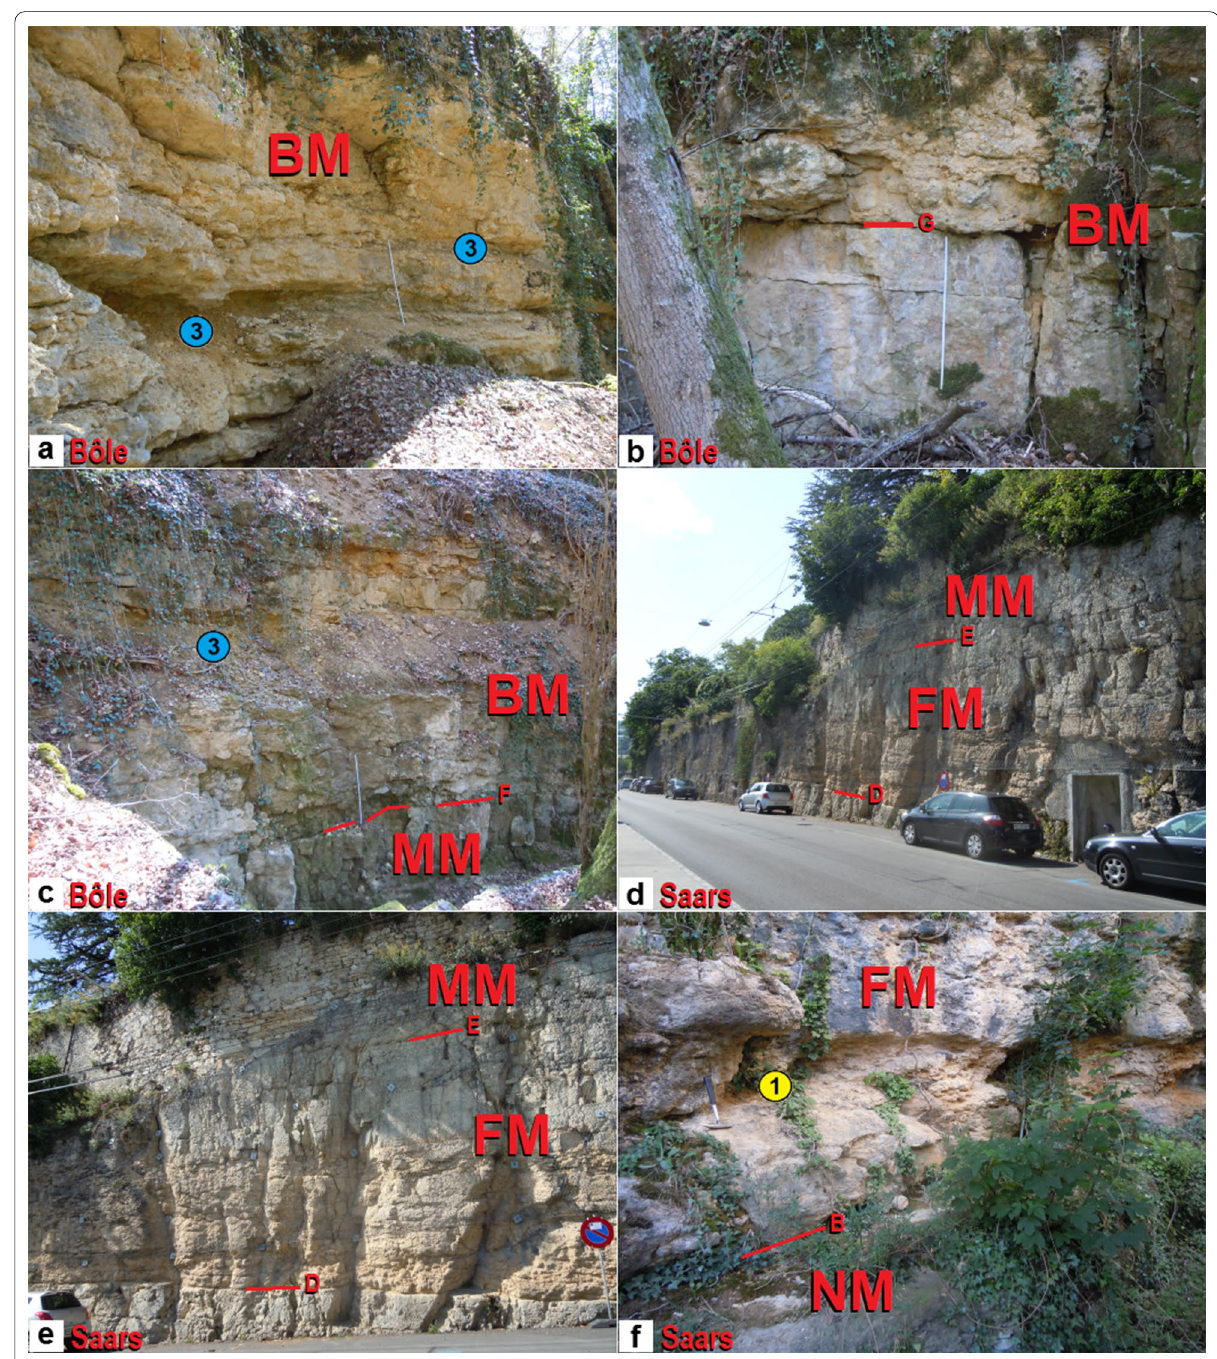
Fig. 5 Saars Formation of the Neuchâtel area (central Jura Mountains). a – c Bôle section. d – f Les Saars‑Le Mail section ( f : ancient shore of Lake Neuchâtel). Captions: NM: Neuchâtel Member; FM: Falaises Member; MM: Montcherand Member; BM: Bôle Member. For the reported discontinuities (B, D, E, F, G) and ostracod assemblages (colored circles 1, 2, 3), see Figs. 10 and 11. Detailed scales are indicated by white foldable ruler of 1 m ( a – c ) and hammer ( f ) of 31.5 cm